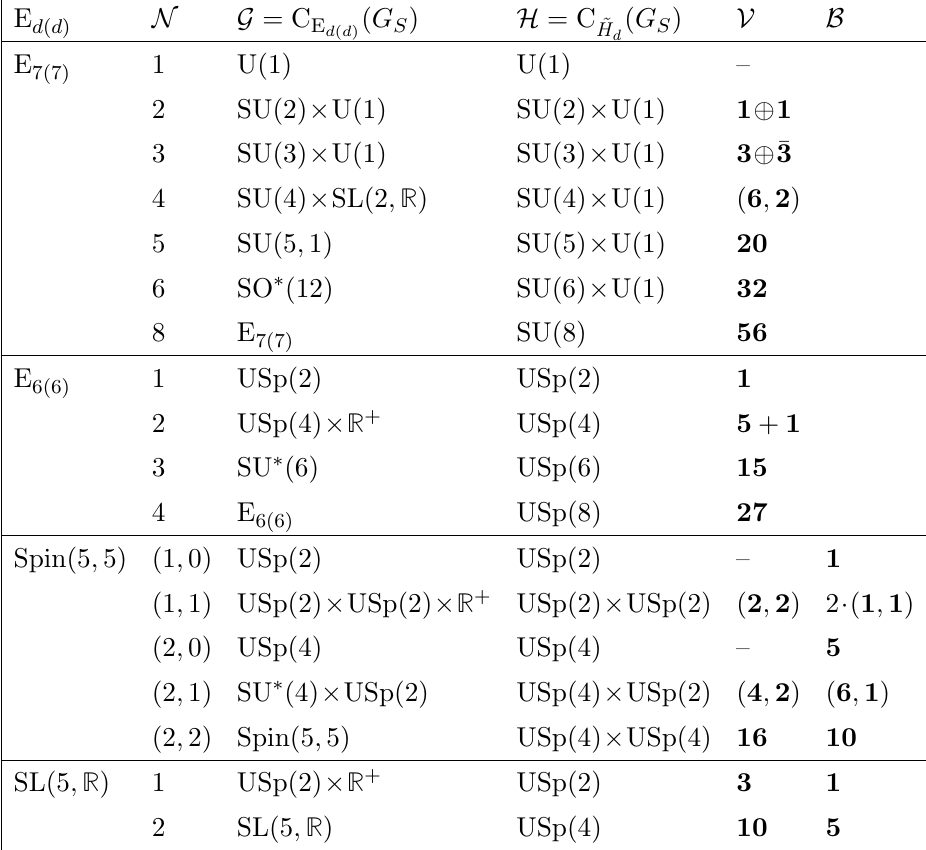
Table 3 . Commutant groups and G -representations of vectors and two-forms for G N -structure consistent